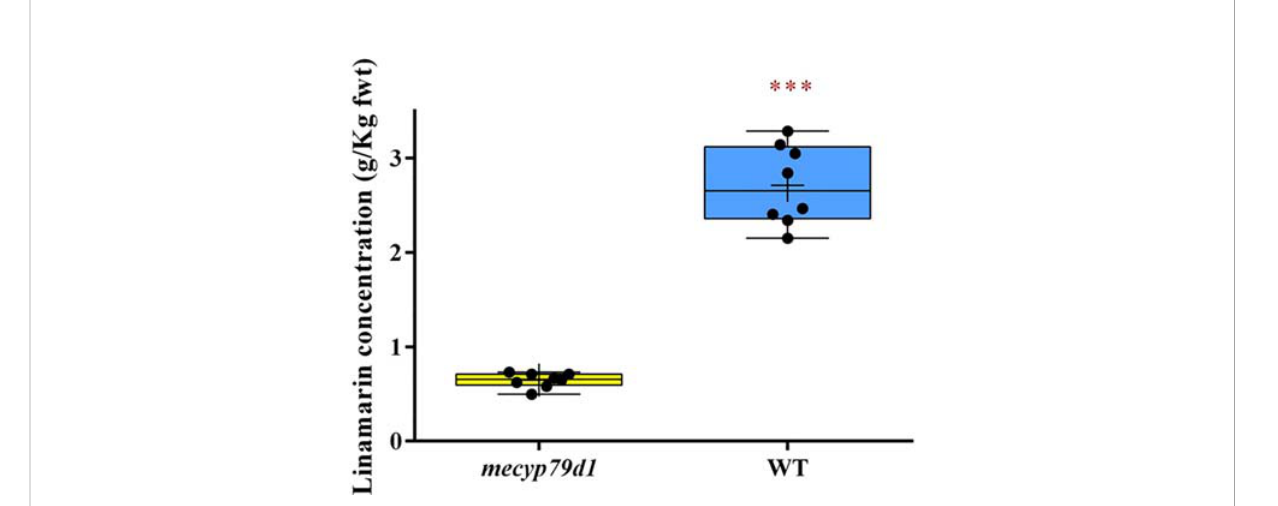
FIGURE 3 Total linamarin concentration in crude extract from freshly ground cassava leaves. Asterisk indicates statistically signi fi cant difference at p<0.05). fwt (fresh